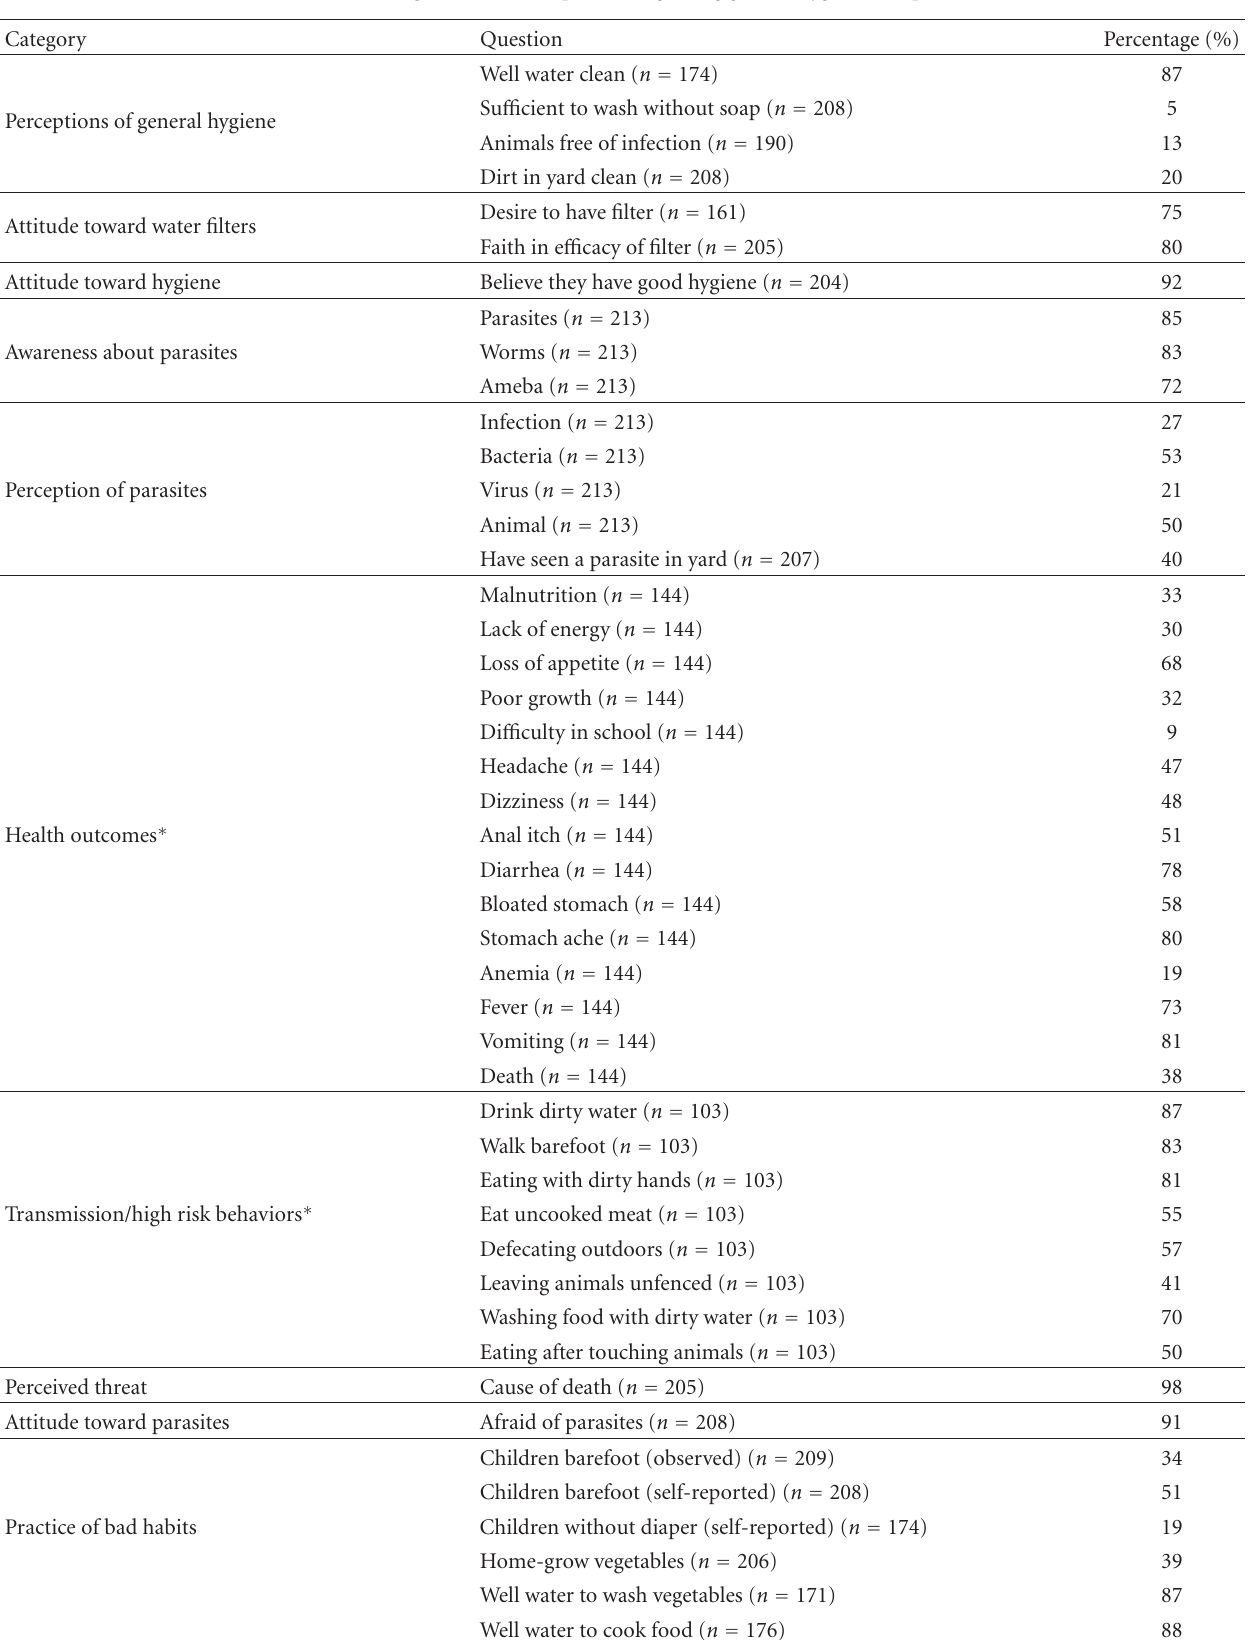
Table 2: Knowledge, attitude, and practice regarding general hygiene and